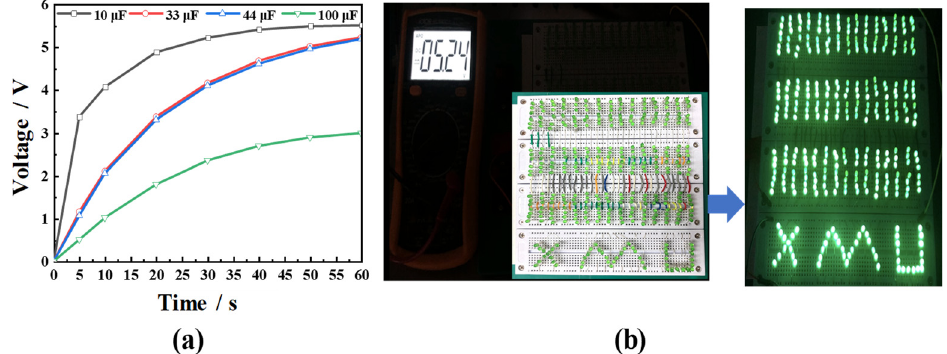
Figure 15. Demonstration of the proposed PVEH powering a capacitor: ( a ) the charging effect of different capacitors in the same time; ( b ) 333 LEDs lit in parallel.